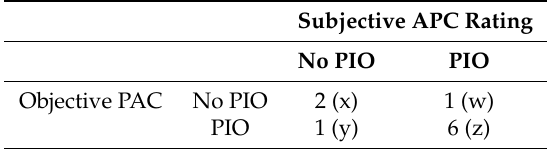
Table 9. Comparison between PAC detections and pilot subjective